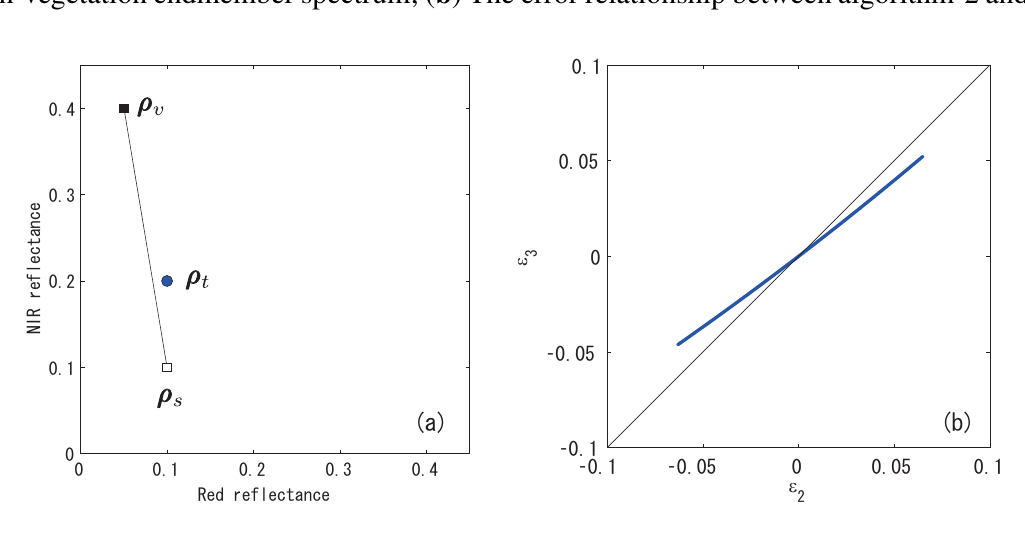
and (cid:15) . ( a ) The target spectrum, vegetation 2 3